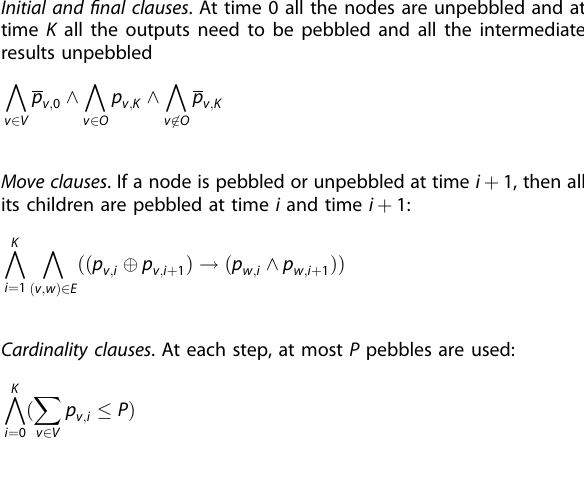
Algorithm 3: minimizing the number of